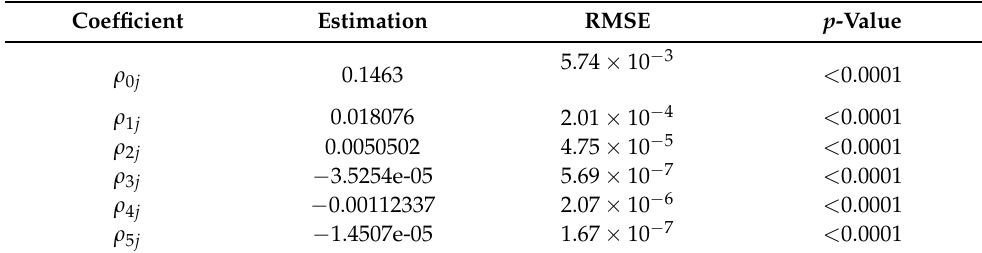
Table 1. Operating Coefficients—Estimation by Nonlinear Regression.